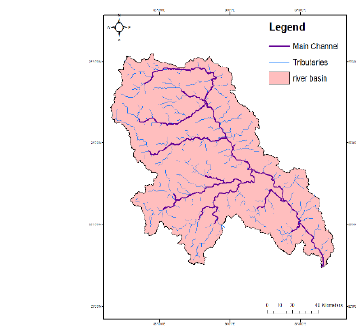
Figure 2(b): Trunk stream network of upper watershed of River